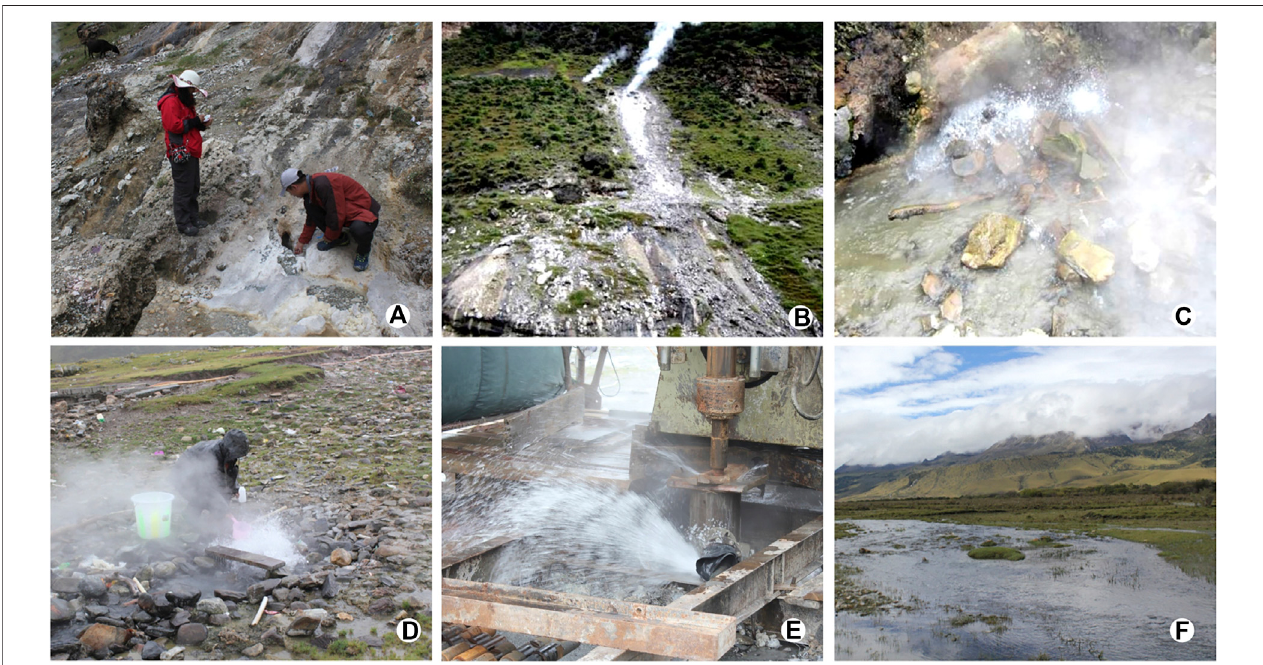
FIGURE 2 | Field photo of Chaluo hot spring. (A) Hot pit spring mouth lower development of spring water; (B) Hot pit boiling spring waterfall; (C) Hot pit boiling spring; (D) Hot water pond boiling spring; (E) Geothermal well near hot water pond; (F) Baqu River water.